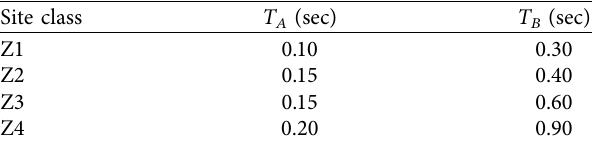
Table 2: Spectrum characteristic periods, T